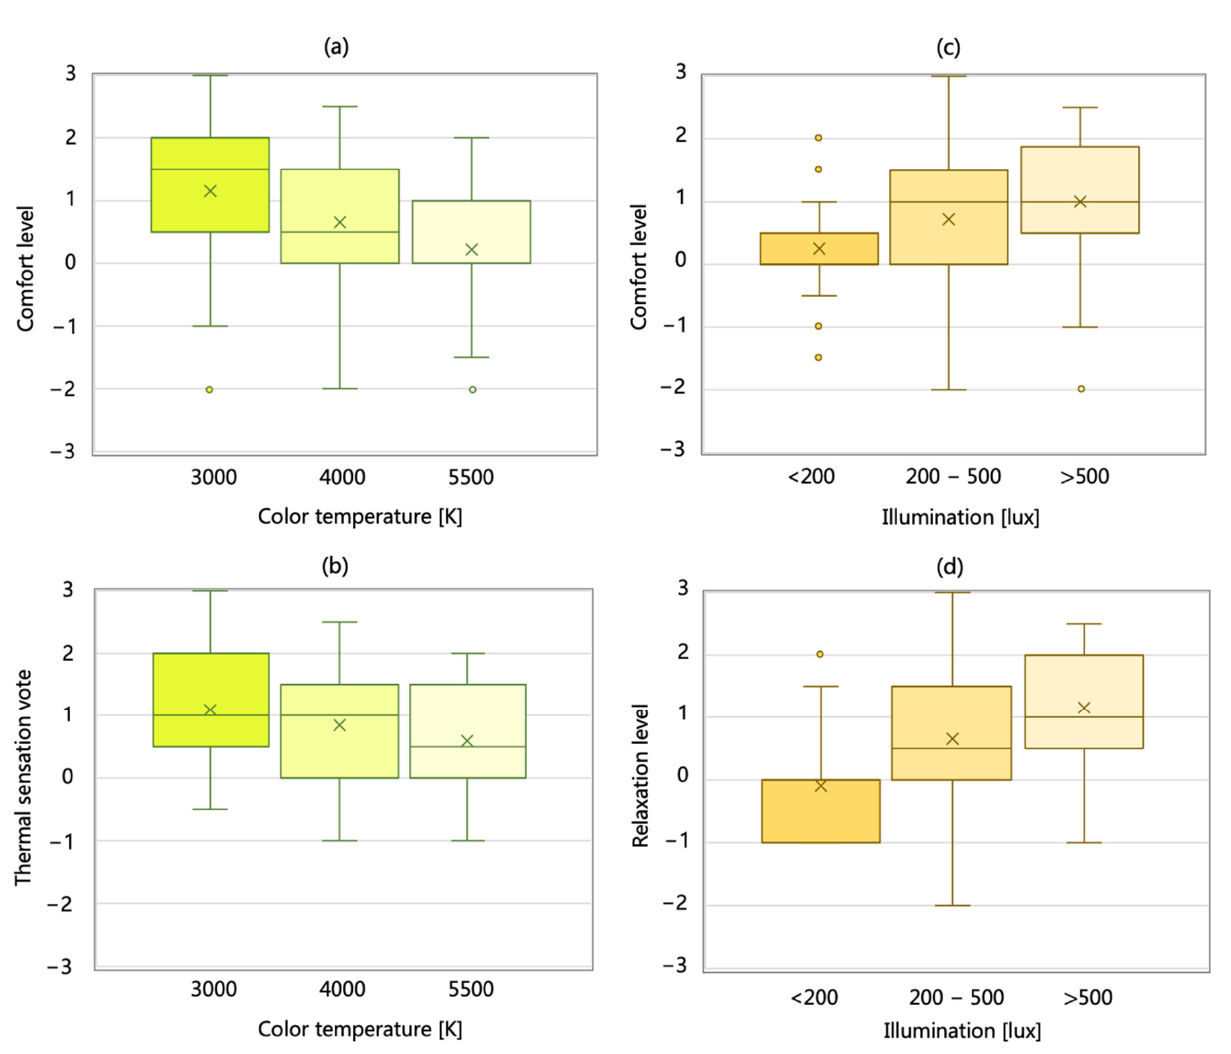
Figure 3. Comfort level and thermal sensation votes of different CCTs and illumination: ( a ) The comfort level of subjects under different CCTs; ( b ) The difference in psychological evaluation of thermal sensation under different CCTs; ( c ) The comfort level under different levels of illumination; ( d ) The relaxation level under different levels of illumination.